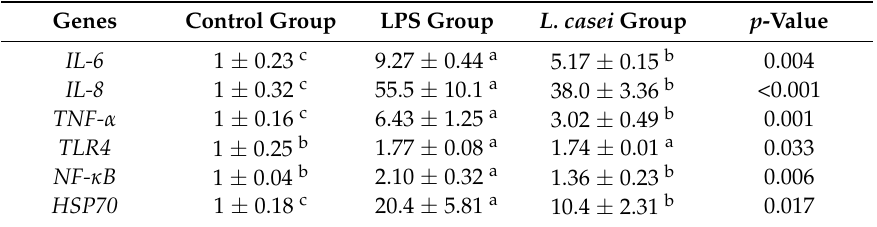
Table 5. Compared with the control group, LPS-challenged piglets had higher ( p < 0.05) mRNA levels for IL-6 , IL-8 , TNF- α , TLR4 , NF- κ B , and HSP70 in the liver. However, the increases in hepatic IL-6 , IL-8 , TNF- α , NF- κ B , and HSP70 were attenuated ( p < 0.05) in piglets receiving the L. casei -supplemented diet. The mRNA expression of hepatic TLR4 was not altered by L. casei supplementation ( p > 0.05). Table 5. Effects of dietary supplementation with L. casei on mRNA levels for inflammatory genes in the liver of piglets.